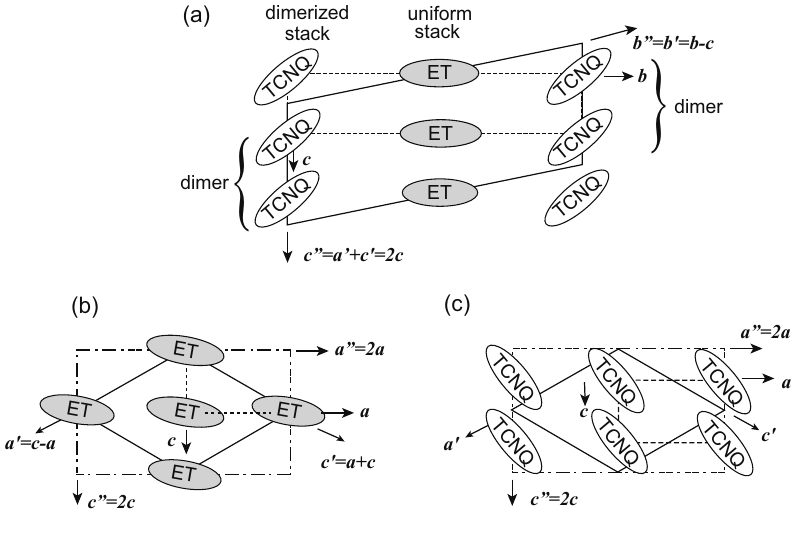
Figure 5. Arrangement of molecules in β″ -(BEDT-TTF)(TCNQ). Average lattice (dotted line; crystal axes are a , b , and c ), superlattice above 170 K (solid line; crystal axes are a ′ , b ′ , and c ′ ), and superlattice 2 a × 2 c below 170 K (dash dot line; crystal axes are a ″ , b ″ , and c ″ ). Arrangement in ( a ) BEDT-TTF (ET) and TCNQ; ( b ) BEDT-TTF; and ( c )